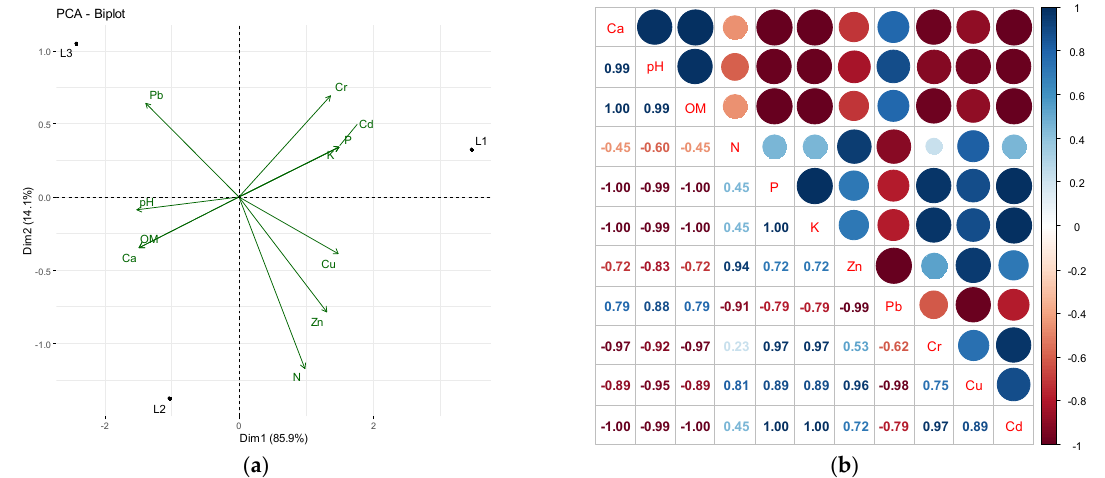
Figure 2. Principal components analysis (PCA) ( a ) and heatmap of Pearson moment correlation coefficients ( b ) for the soil’s chemical properties (CaCO 3 —Ca, pH, organic matter—OM, total N—N, P 2 O 5 —P, K 2 O—K, Zn, Pb, Cr, Cu, and Cd) at analyzed localities.